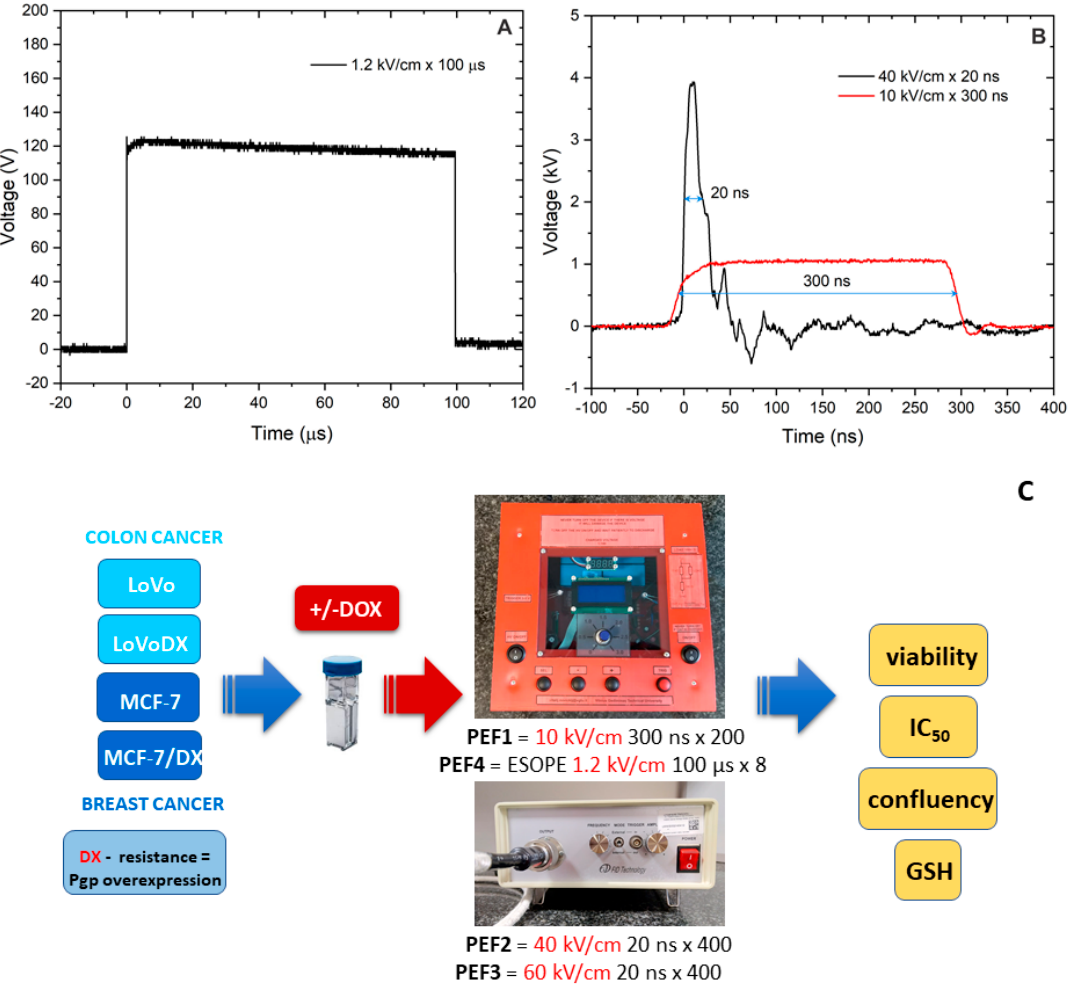
Figure 1. The waveform of ( A ) long- and ( B ) short-duration pulses and ( C ) graphical representation of the experimental setup.